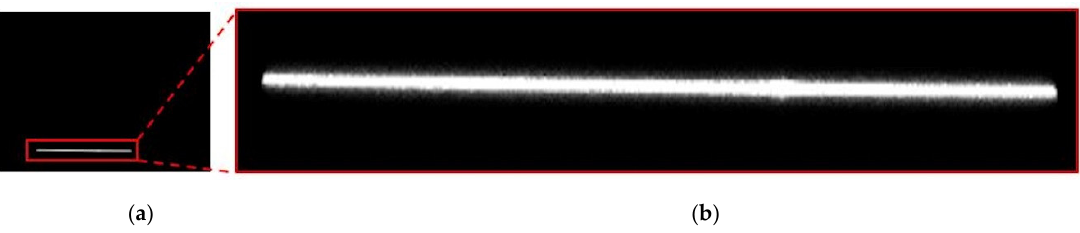
Figure 1. Laser line displayed horizontally in the image: ( a ) complete image taken by the camera; ( b ) laser line section obtained from the complete image.